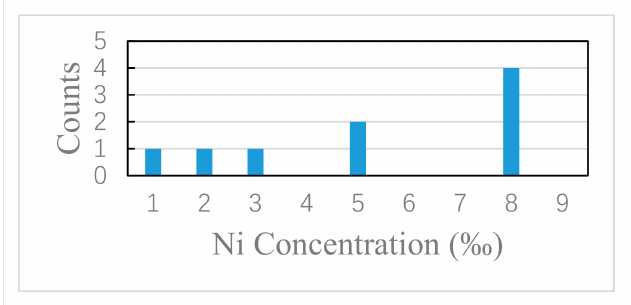
Figure 2. Ni concentration in nine SmB 6